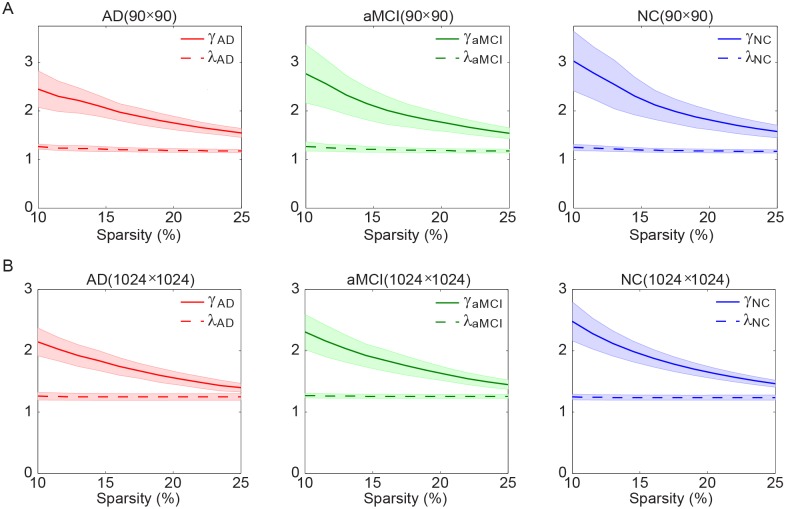
Small-world network metrics of functional brain networks at two different parcellation scales.The graphs show the changes in γ (solid line) and λ (dashed line) in the functional brain networks of AD (red), aMCI (green), and NC (blue) groups at (A) low parcellation scale and (B) high parcellation scale with respect to sparsity. For all the three groups, γ was significantly greater than 1 and λ was relatively close to 1, indicating prominent small-world properties for all groups.